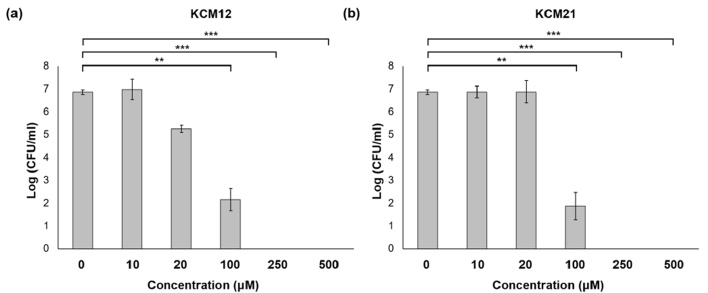
Figure 2. Antibacterial e ffi cacy of hexapeptides ( a ) KCM12 and ( b ) KCM21 against Pst DC3000 under various concentration, (** significant at p ≤ 0.01 between control (0 µ M) and KCM12- or KCM21-treatment and *** significant at p ≤